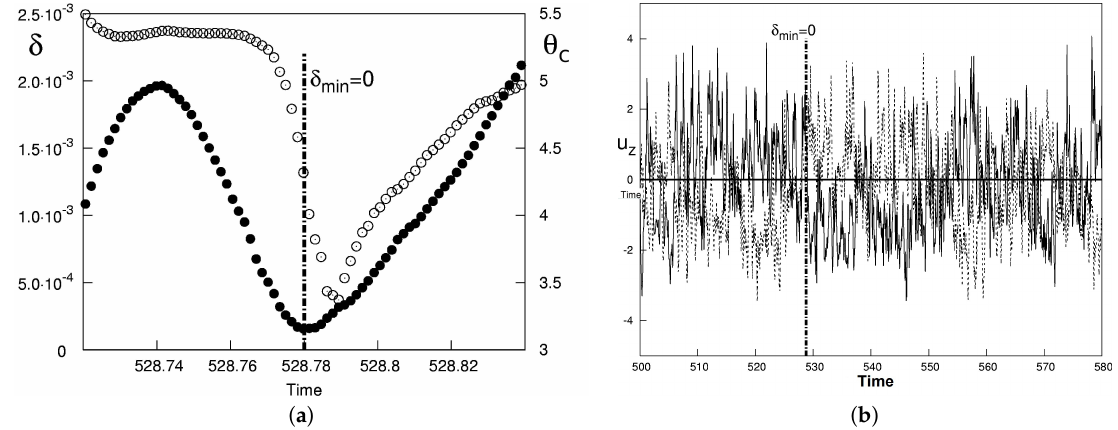
Figure 5. ( a ) θ 0 orientation ( (cid:12) ) (radiant) and δ amplitude ( • ); ( b ) flow axial velocity time history sampled at two symmetric points in the azimuthal direction θ 3 = 3 π /4 (solid line) and θ 7 = 7 π /4 (dashed line). The wind reversal for the rotation shown in ( a ) it is in agreement with the switching of the flow axial velocity as shown in ( b